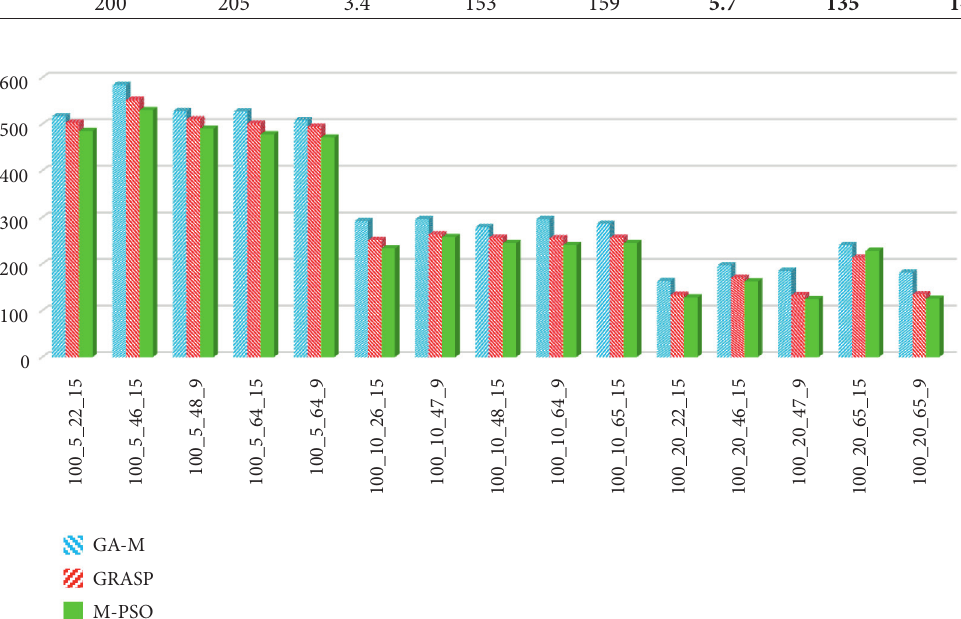
Figure 5: Comparing BEST values between GA-M, GRASP, and M-PSO of 100 tasks